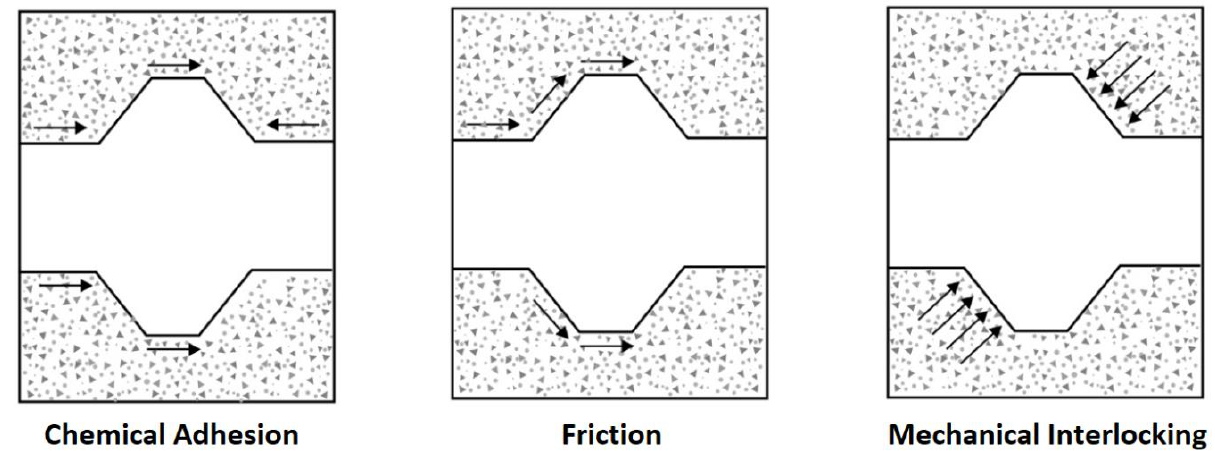
Figure 2. The bond mechanism between concrete and reinforcement bar [24].